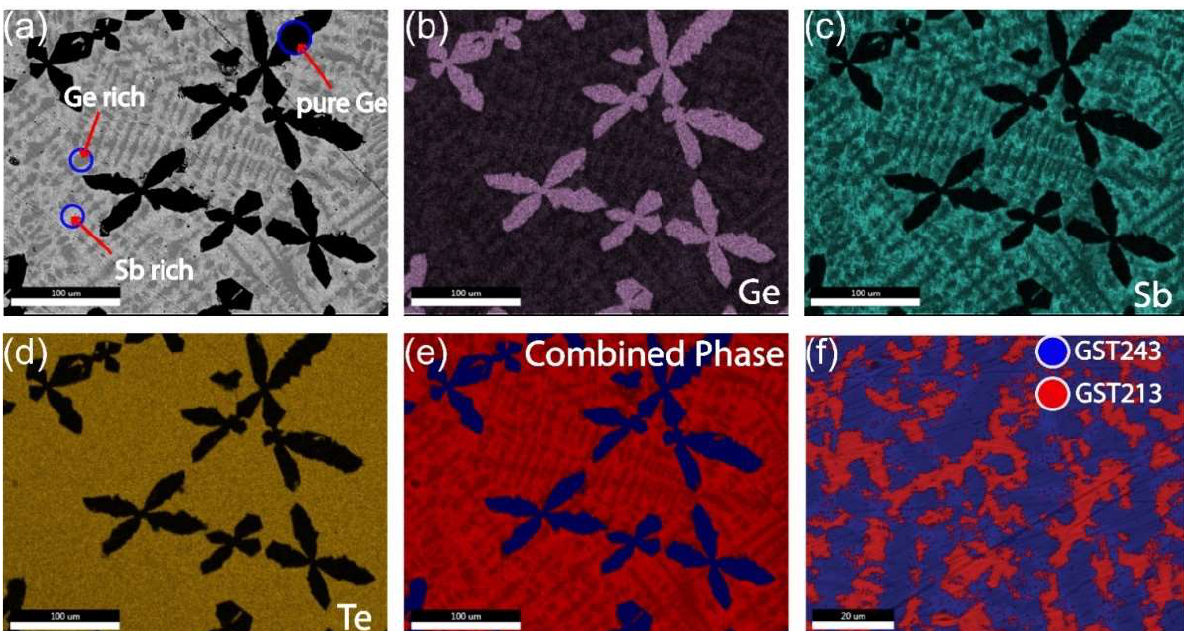
Figure 1. SEM–EDX mapping of water-quenched crystalline alloy showing the formation of multiple phases. ( a ) SEM image showing the formation of Ge dendrites from the excess germanium in the system and other phases. ( b ) Ge, ( c ) Sb, and ( d ) Te elemental maps. ( e ) A combined (Ge, Sb, and Te) elemental mapping with clear color contrast shows three phases. ( f ) When taken away from the pure Ge dendrites, an elemental map shows two distinct phases. The scale bar in ( a – e ) is 100 μm and in ( f ) is 20 μm.